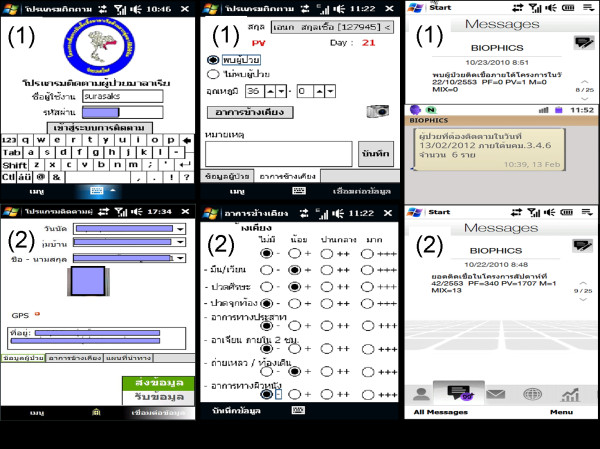
Screenshots of mobile-phone applications and SMS alert system. (a-1) Login screen of the password-secured mobile phone system; (a-2) Infected-case details with patient name and picture (as per permission), appointment date, address to be submitted online or offline during case investigation or home visit follow-up; (b-1) Case follow-up details on temperature, side effects, and other remarks; (b-2) Check boxes of atypical malaria signs and symptoms captured during home visit follow-ups; (c-1) Daily SMS alert messages – Day 0 alert informing number of cases within the specific malaria clinic area of responsibility, and a case follow-up alert informing number of cases to be followed up on a particular day; (c-2) Weekly SMS alert messages informing of the cumulative number of cases, particularly for each level of the vertical malaria control programme, from local operational units to ministerial management level.